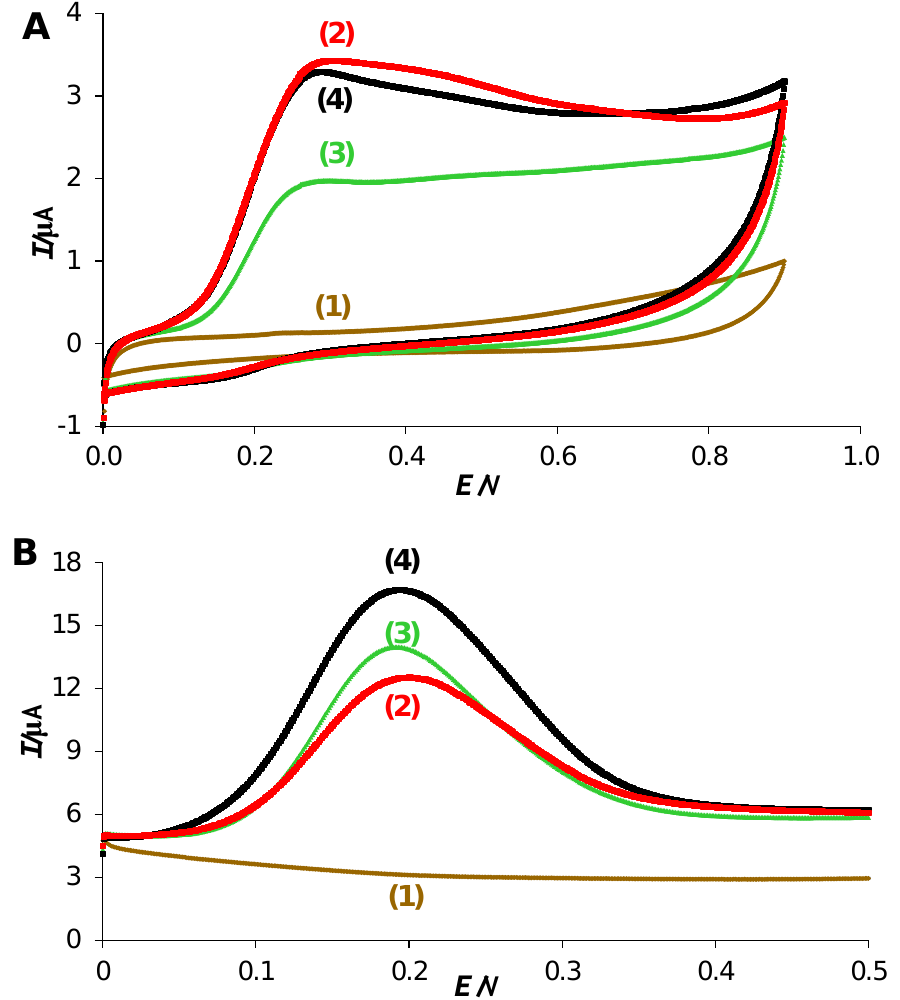
Figure 4. Determination of antioxidant capacity by cyclic voltammetry of lingonberry samples. ( A ) Cyclic voltammograms of lingonberry extracts at concentration of 1 mg/mL in 0.1 M phosphate buffer (pH = 7.3) recorded at potential scan rate of 10 mV/s at glassy carbon electrode. ( B ) Square wave voltammograms. For both panels: blank (1); copigment fraction (2); anthocyanin fraction (3); and XAD-7 (4). The parameters of the potential modulation for square wave voltammograms are: starting potential E 1 = 0.0 V, square wave frequency f = 10 Hz, the height of the potential pulses E sw = 50 mV and the step potential ∆ E = 1 mV.